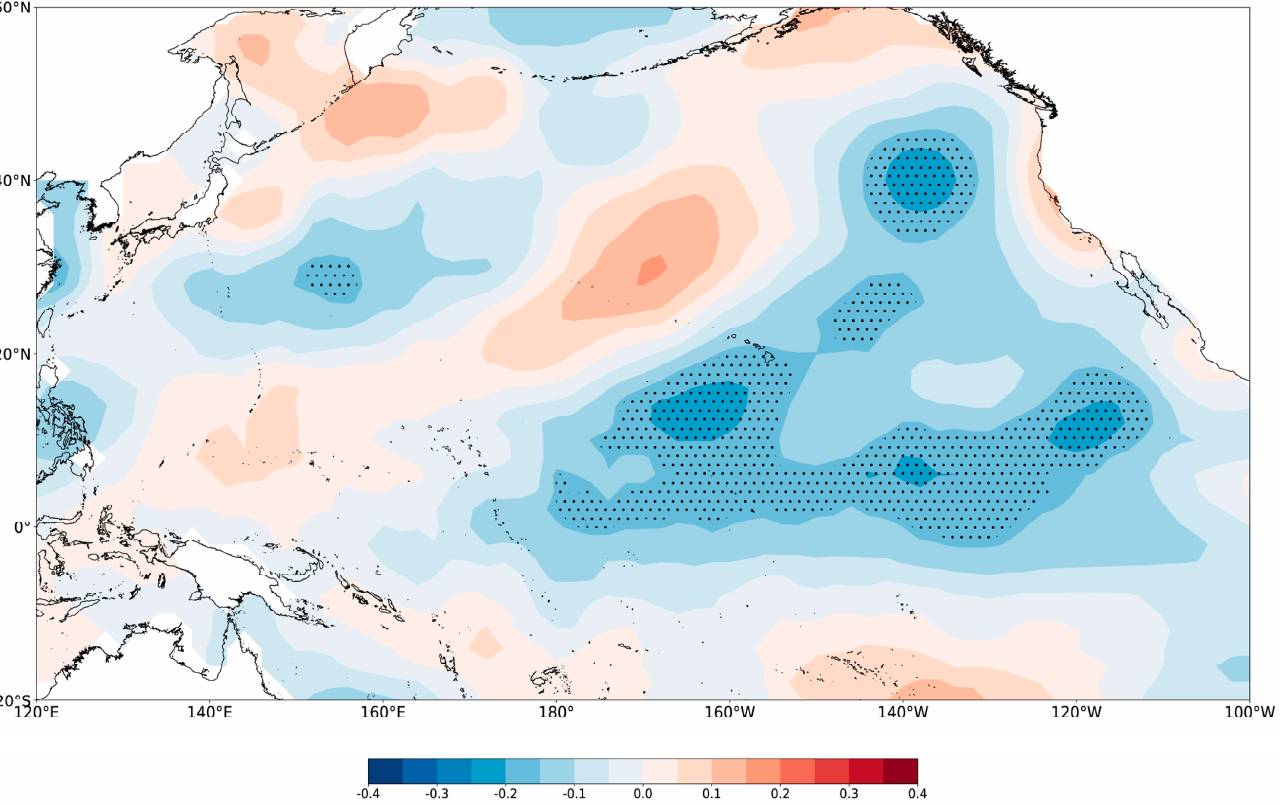
Figure 9. Spatial correlations between the reconstruction and sea surface temperature (SST) during the period of 1854–2010. The do tt ed area indicates 95% con fi dence.